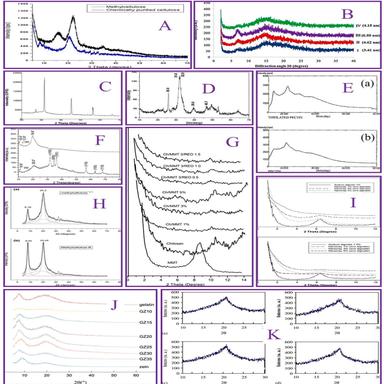
XRD Profiles of, (A). Chemically purified cellulose (black) vs Methylcellulose (blue) , (B). (I) Kefiran film and gamma-irradiated kefiran films at different dosages say, (II) 3 kGy, (III) 6 kGy and (IV) 9 kGy, (C). Polyhydroxy Butyrate extracted from Botryococcus braunii kütz, (D). Nano-hydroxyapatite/chitosan–pectin (nHCP) composite, (E). (a) Pectin, (b) Thiolated Pectin , (F) (a) Chitosan membrane and (b) Chitosan nano- ZnO composite mem